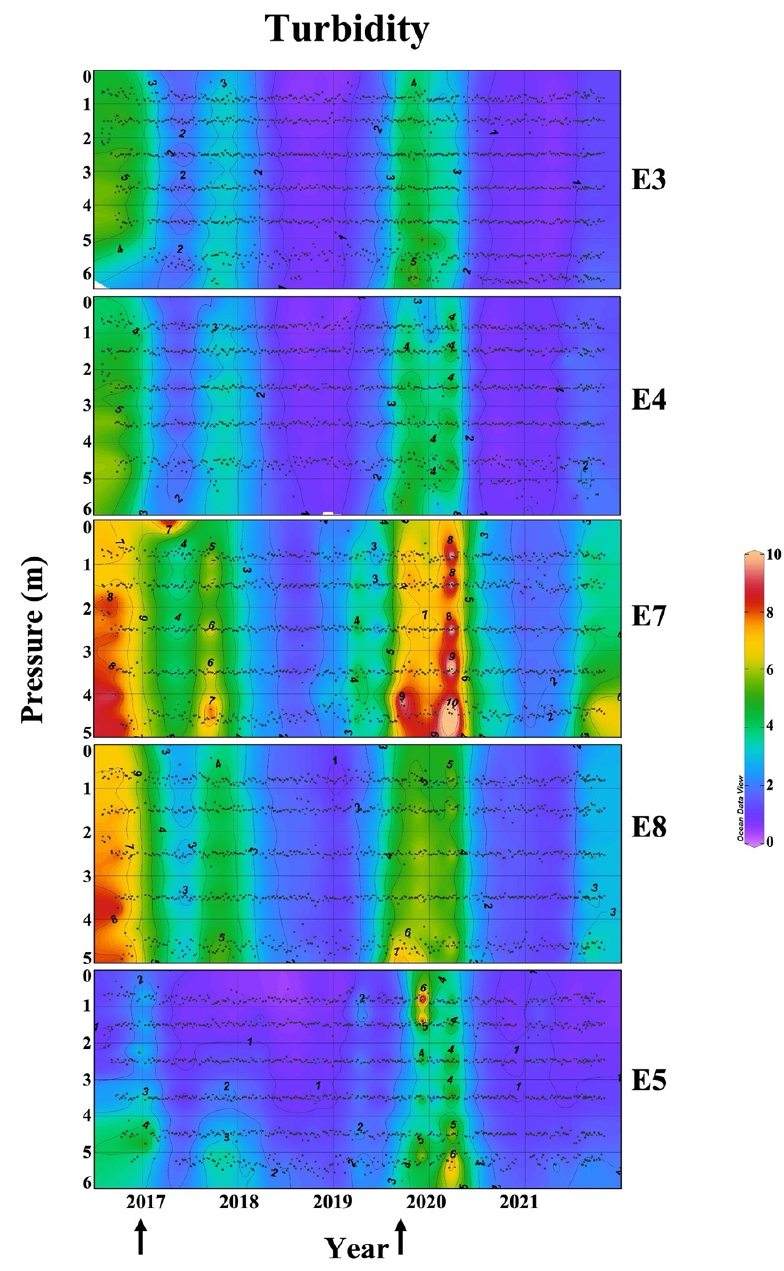
Figure 7. Temporal evolution of turbidity at stations E3, E4, E7, E8, and E5 from August 2016 to October 2021. The vertical arrows indicate when the two DANA events occurred (December 2016 and September 2019, respectively).